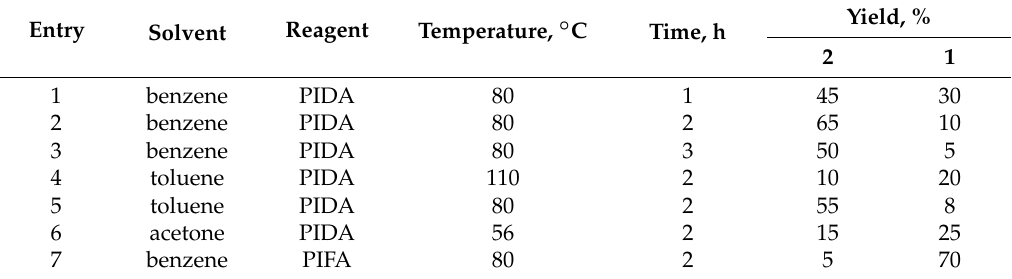
Table 1. Reaction of 3,6-dichloro-5-nitropyridazin-4-amine 1 with oxidizing